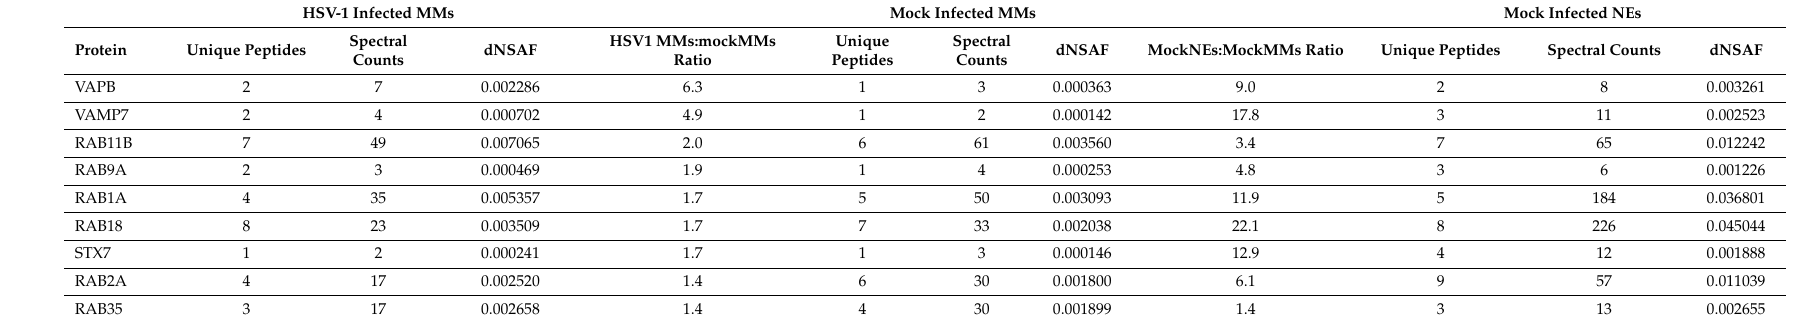
Table 2. Peptide and spectral counts for VAPB proteins passing the candidate